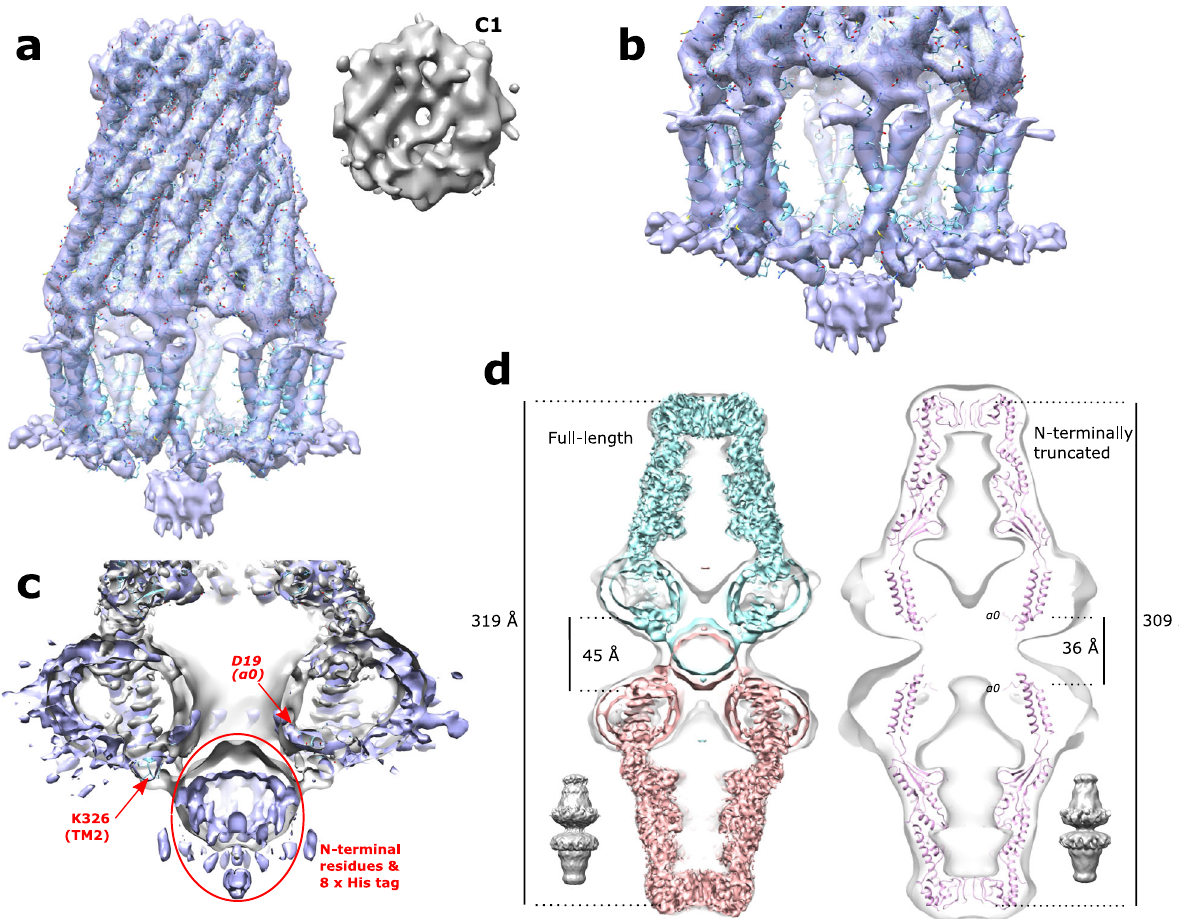
Fig. 5 Structure of N-terminally truncated WzzB. a Docked atomic model to the N-terminally truncated WzzB C8-symmetrized map. Top right: view from the top of the periplasmic domain showing an octameric complex similar to the full-length WzzB in the unsymmetrized map. b Zoom of the transmembrane region, showing a similar architecture to the full-length WzzB. c Overlay of the full-length (gray) and N-terminally truncated (purple) WzzB. An equivalent threshold was chosen based on the visually similar size of the detergent micelles of both maps. d Docking into the dimeric forms. Left: to show the overlap of the two cytoplasmic domains in the dimeric form, two full-length monomeric octamer maps (cyan and salmon-colored) are docked into the full-length dimer (gray outline and bottom left). Equivalent thresholds were chosen based on the visually similar size of the detergent micelles of the monomeric and dimeric forms. Right: two atomic models docked into the N-truncated dimer (gray outline and bottom